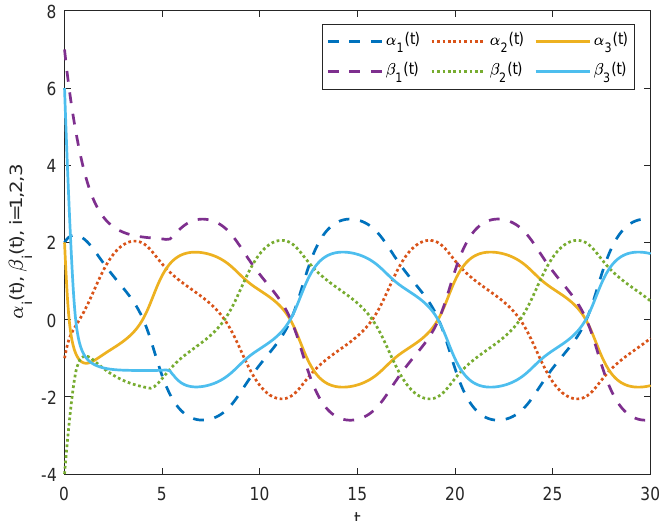
Figure 7. Schematic of the master system α ( t ) and the slave system β ( t ) under the saturated aperiodic SD controller of Example